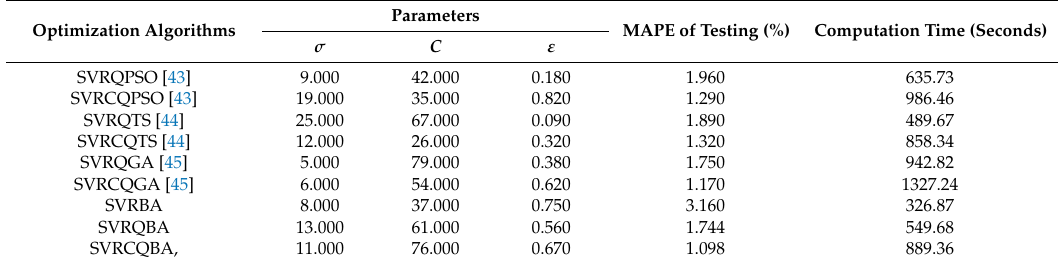
Table 1. Parameters combination of SVR determined by CQBA and other